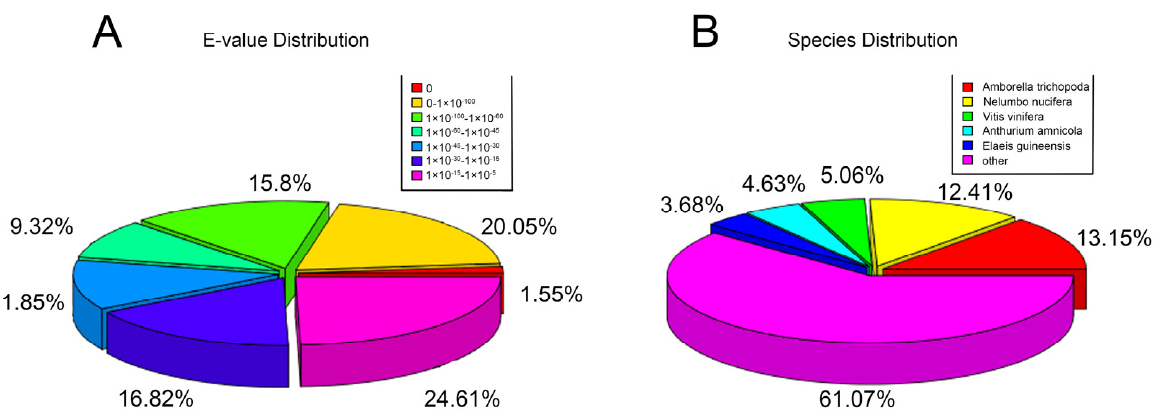
Figure 3. NCBI-NR annotations. ( A ) NCBI-NR annotated species distribution map. ( B ) E value distribution of NCBI-NR annotation.